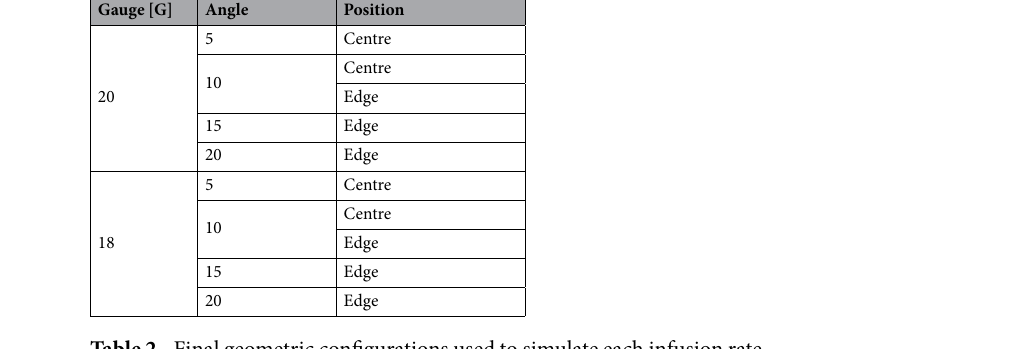
Table 2. Final geometric configurations used to simulate each infusion